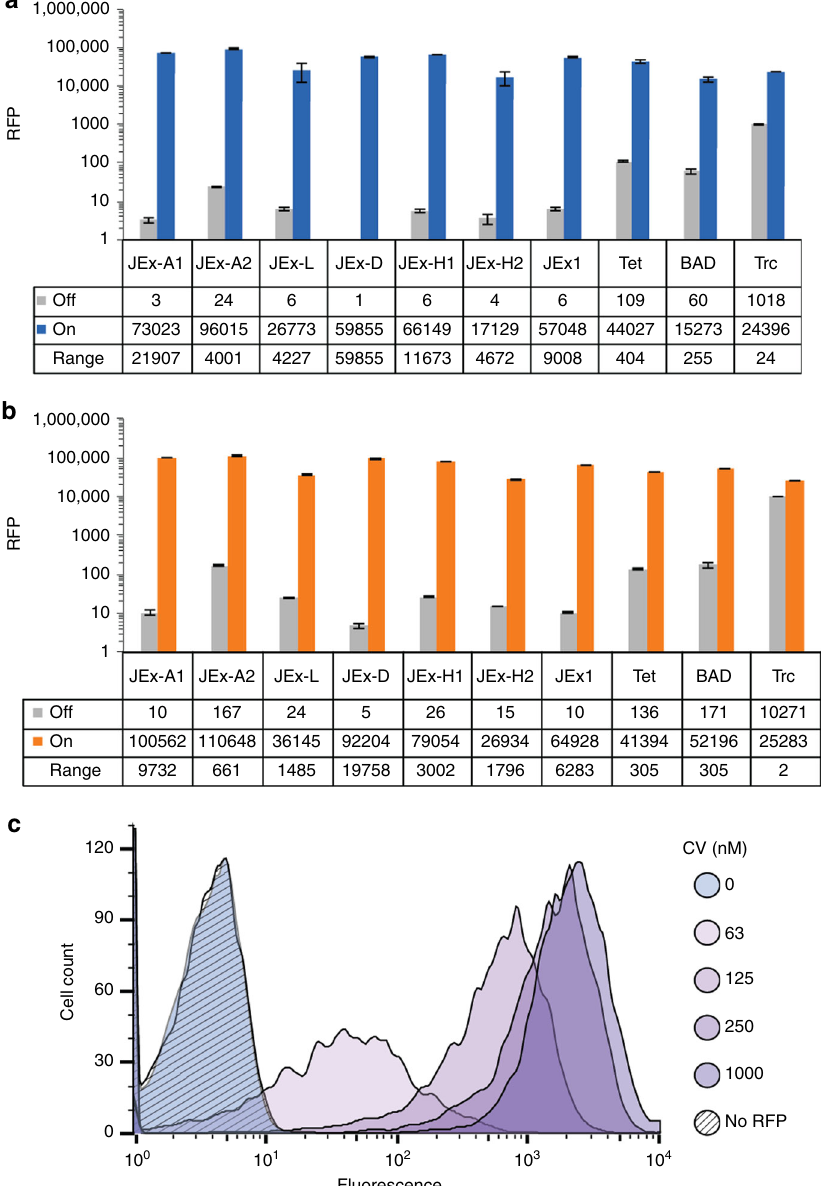
Fig. 3 RFP expression from EilR-regulated promoters in E. coli . Single-cell fl uorescence of E. coli expressing RFP from EilR-regulated and three common inducible promoters after growth in either de fi ned media with 0.2% glucose ( a ) or LB media ( b ). P JEx promoters were induced with 1 µ M CV, P tet with 400 nM anhydrotetracycline, P BAD with 13 mM arabinose and P trc with 1 mM IPTG. c Flow cytometry measurements show the distribution of single-cell fl uorescence of stationary phase populations expressing RFP from P JExD after growth without (blue) or with increasing concentrations of CV (purple). The hatched histogram represents auto fl uorescence of cells lacking rfp . E . coli DH10B was used in a – c , with rfp expressed from medium copy plasmids (p15A ori ). Values and error bars in a and b represent the means and standard deviation of biological triplicate measurements after subtracting background fl uorescence emitted by E. coli lacking